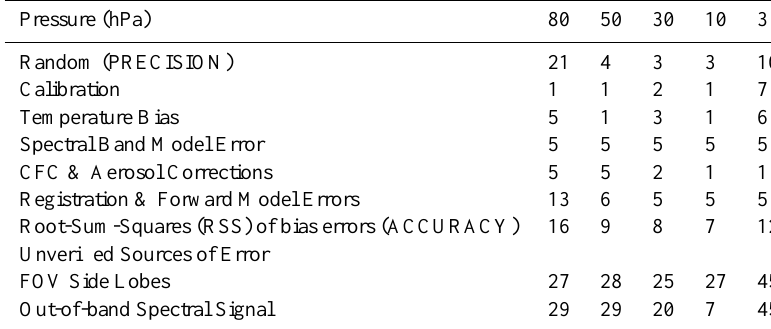
Table 1. Calculations of precision and accuracy (%) for LIMS V6 HNO 3 . Pressure (hPa) Random (PRECISION) 21 4 3 10 Calibration 1 1 2 1 7 Temperature Bias 5 Spectral Band Model Error CFC & Aerosol Corrections Registration & Forward Model Errors Root-Sum-Squares (RSS) of bias errors (ACCURACY) Unverified Sources of Error FOV Side Lobes Out-of-band Spectral